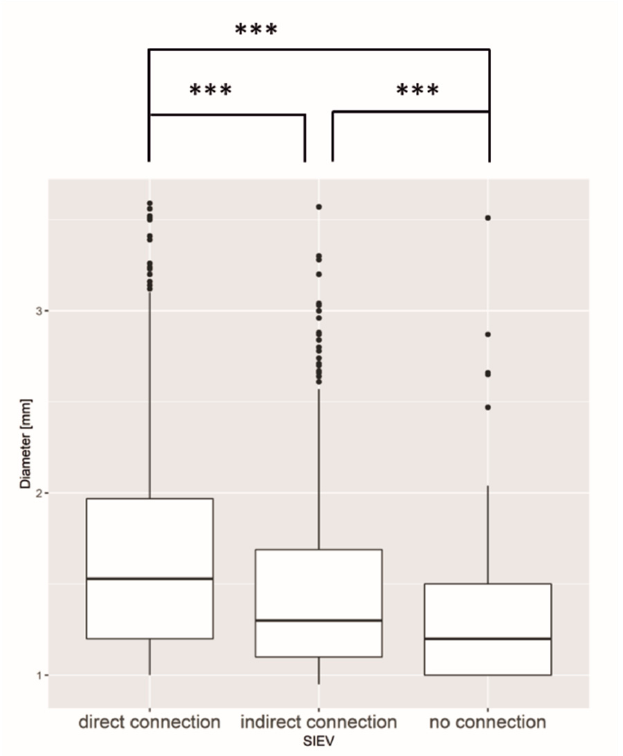
Figure 3. Boxplot of the diameter and different SIEV connections. SIEV = superficial inferior epigastric vein. The diameter of the perforator had a significant influence on the connection to the SIEV. The different connection types varied significantly among themselves. *** = p ≤ 0.001.